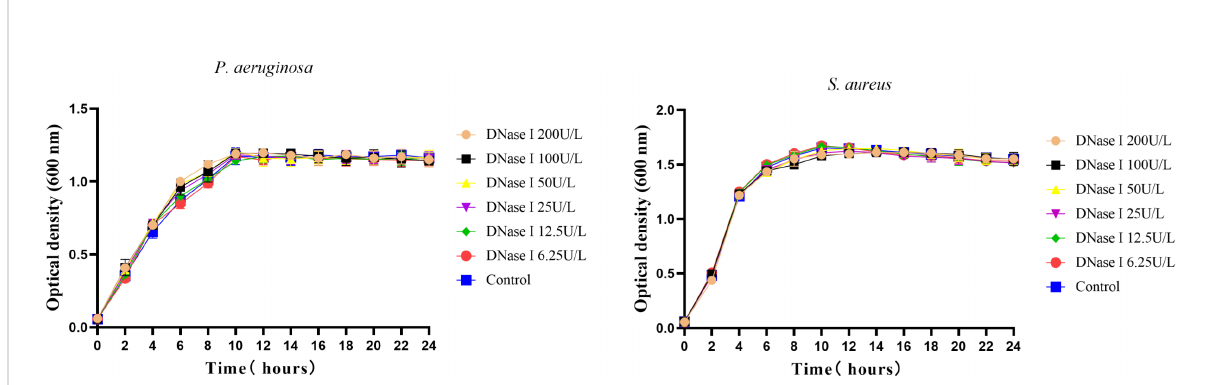
FIGURE 1 Growth curves of P. aeruginosa or S. aureus incubated with different DNase I concentrations or with drug solvent (negative control group). Three wells were set up for each group. The mean values and standard error are shown; DNase I has no effect on the growth of P. aeruginosa or S. aureus . The error bars represent the standard error of the OD600 value for each time point in the growth curves (n =